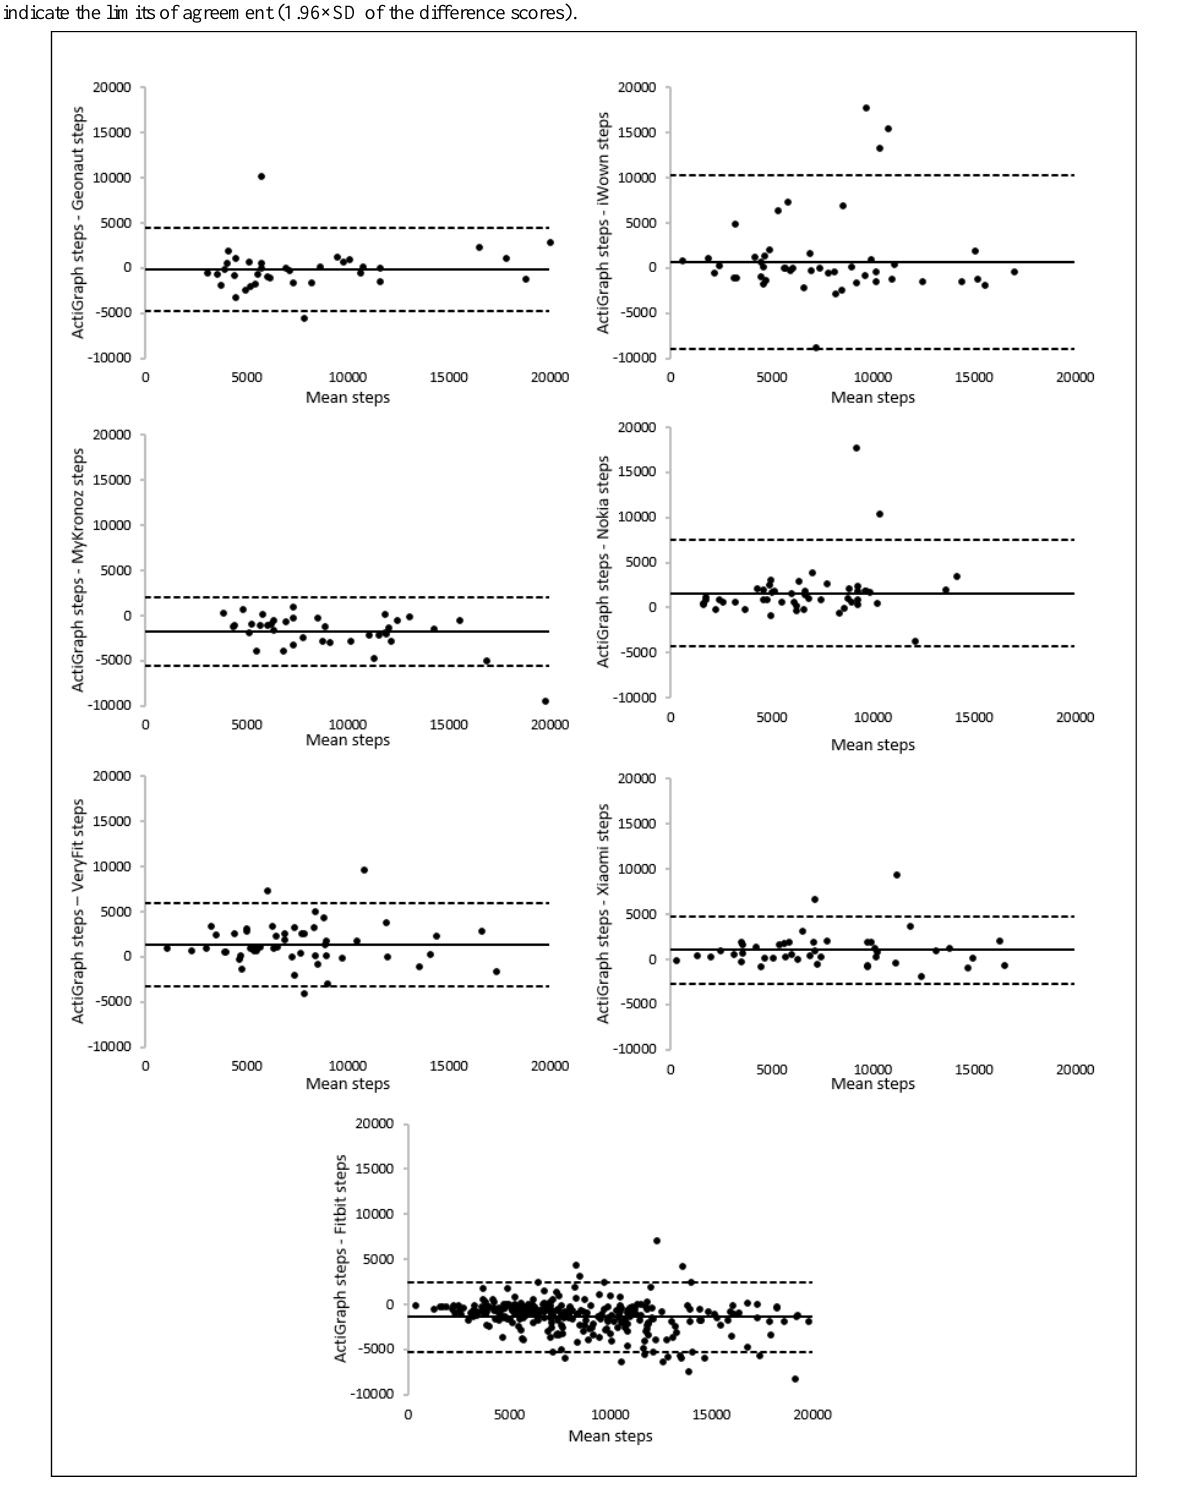
Figure 5. Bland-Altman plots of the trackers for measuring steps. The middle line shows the mean difference (positive values indicate an underestimation of the wearable and negative values indicate an overestimation) between the measurements of steps of the wearables and the ActiGraph and the dashed lines indicate the limits of agreement (1.96×SD of the difference